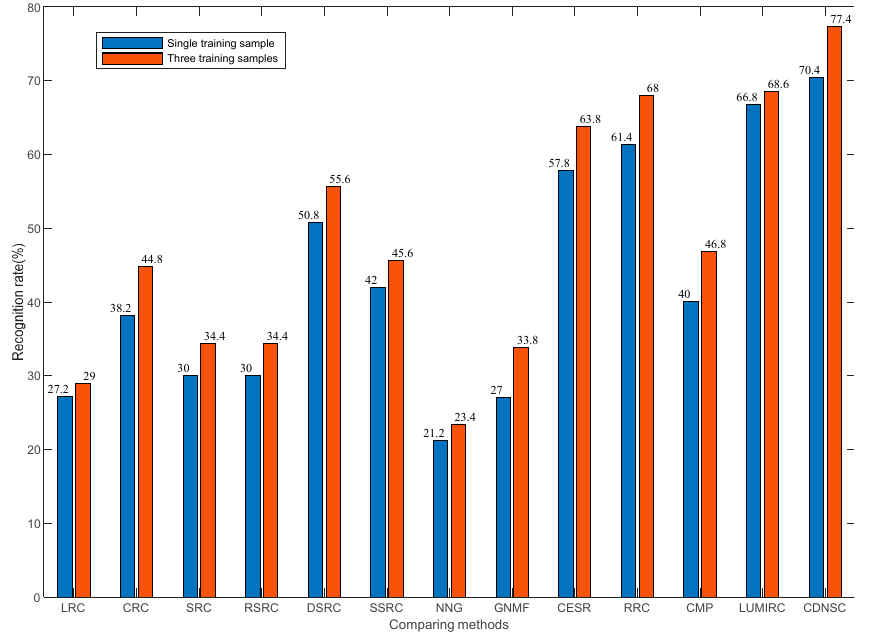
Figure 10. Recognition rate versus the training sample number.